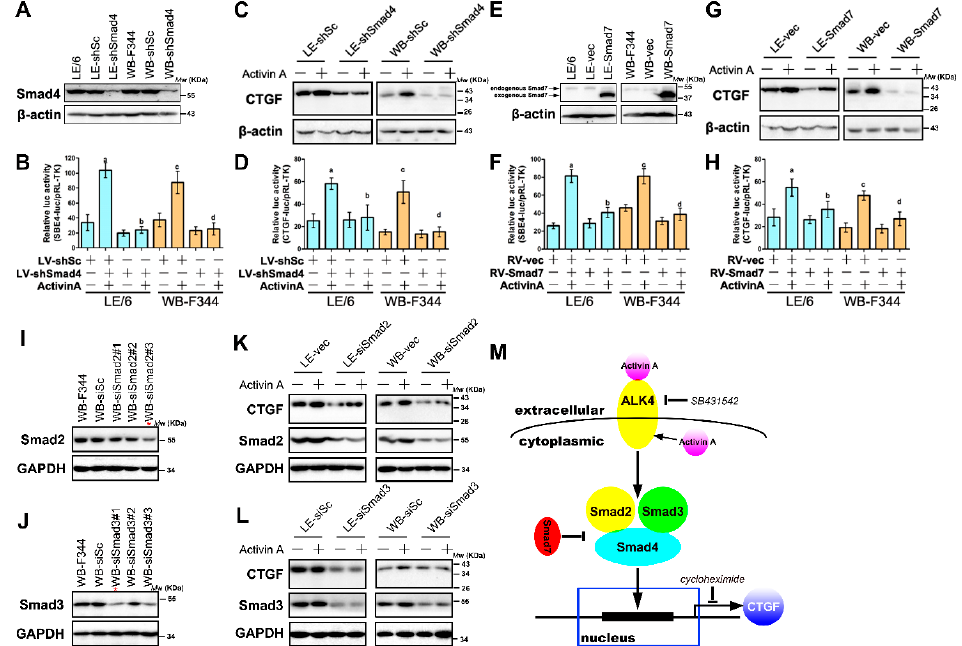
Figure 6. Activin A induced the production of CTGF/CCN2 through Smad signaling in LPCs. ( A , E ) LE/6 and WB-F344 cells were transfected with retrovirus carrying shRNA against Smad4 (WB-shSmad4 or LE-shSmad4 cells) or scramble shRNA (WB-shSc or LE-shSc cells) ( A ), or ectopic expressed Smad7 (WB-Smad7 and LE-Smad7 cells) or vector (WB-vec and LE-vec cells) by retrovirus ( E ), Western blot analyses showed the expression of Smad4 ( A ) and Smad7 ( E ). β -Actin was used as a loading control; ( B , D , F , H ) WB-shSmad4/LE-shSmad4 and WB-shSc/LE-shSc cells ( B and D ); or WB-Smad7/LE-Smad7 cells and WB-vec/LE-vec cells ( F and H ) were co-transfected with pRL-TK and SBE4-luc ( B and F ), or CTGF-luc ( D and H ). Luciferase activity was normalized to renilla luciferase activity and expressed as the means ˘ S.E.M. of triplicate measurements; the bars were compared as follows: a, p < 0.05, second with first; b, p < 0.05, fourth with second; c, p < 0.05, sixth with fifth; d, p < 0.05, eighth with sixth); ( C , G ) WB-shSmad4/LE-shSmad4 and WB-shSc/LE-shSc cells ( C ); or WB-Smad7/LE-Smad7 cells and WB-vec/LE-vec cells ( G ) were treated with Activin A (50 ng/mL) for 6 h. Lysates were subjected to Western blot analyses with antibodies against CTGF/CCN2. β -Actin was used as a loading control; ( I , J ) WB-F344 cells were transfected with siRNA duplexes targeting rat Smad2 ( I ), or Smad3 ( J ), or scrambled siRNA, and cell lysates were subjected to immunoblotting assay with antibody against Smad2 ( I ) or Smad3 ( J ). GAPDH was used as a loading control. *, siRNA ( K , L ) WB-F344 and LE/6 cells were transfected with validated specific siRNAs against Smad2 (siSmad2 cells) ( K ), or Smad3 (siSmad3 cells) ( L ), or scramble shRNA (siSc cells) and transfected cells were antibodies against CTGF/CCN2, and Smad2 ( K ) or Smad3 ( L ). GAPDH was used as a loading control; ( M ) Schematic illustrations of the Activin A signaling in the expression of CTGF/CCN2 in LPCs. Exogenous and endogenous Activin A activates and receptor I (ActRIB, ALK4) ( Ó ), leading to the phosphorylation and activation of Smad2 and Smad3 ( Ó ), which form a complex with Smad4 to induce the de novo synthesis of CTGF/CCN2 ( Ó ). Both Smad2 and Smad3-regulated signaling contribute